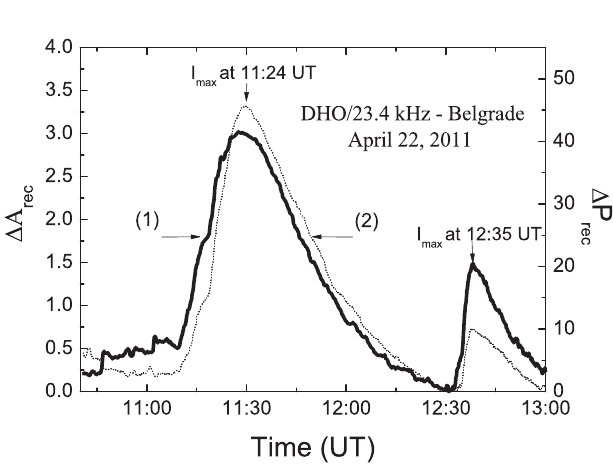
Fig. 1. Perturbed amplitude (1) and phase (2) of a signal emitted from DHO trans- mitter (Germany) and recorded by the AWESOME receiver in Belgrade (Serbia) during the observed flares. Null values correspond to the amplitude and phase recorded for the unperturbed